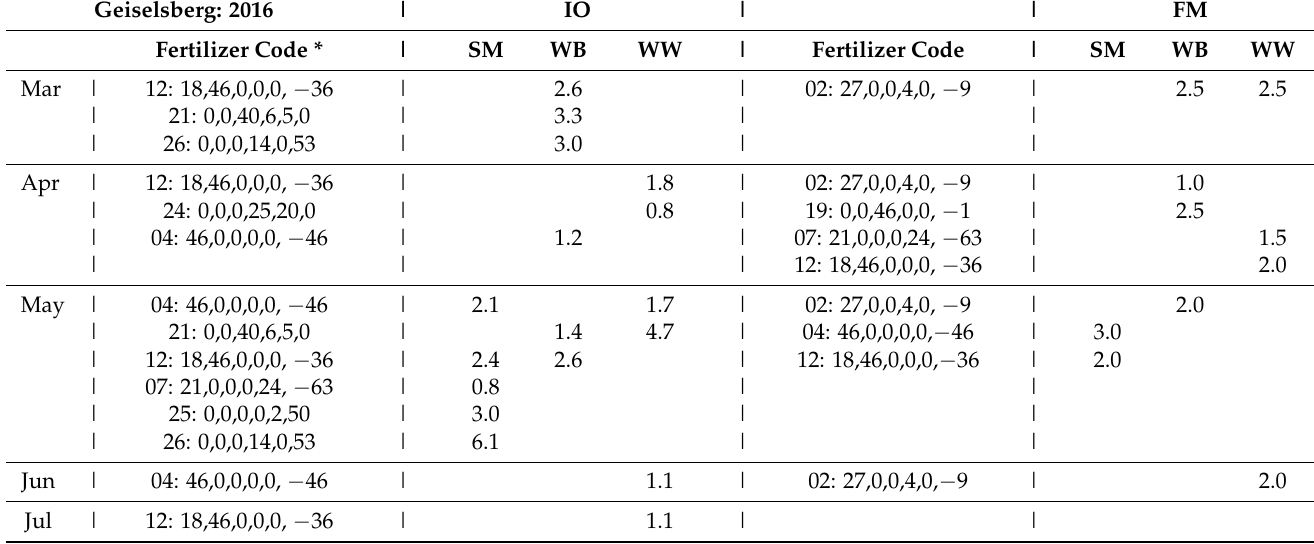
Table A1. Detailed documentation of fertilizer application in dt per hectare (1 dt = 100